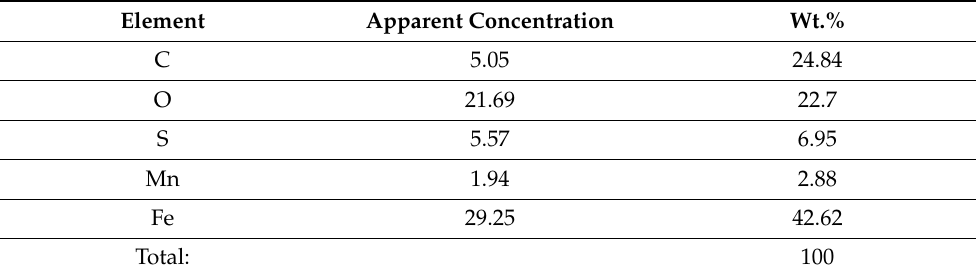
Table 1. EDX data of 3%S@MnFe 2 O 4 nanoparticles.